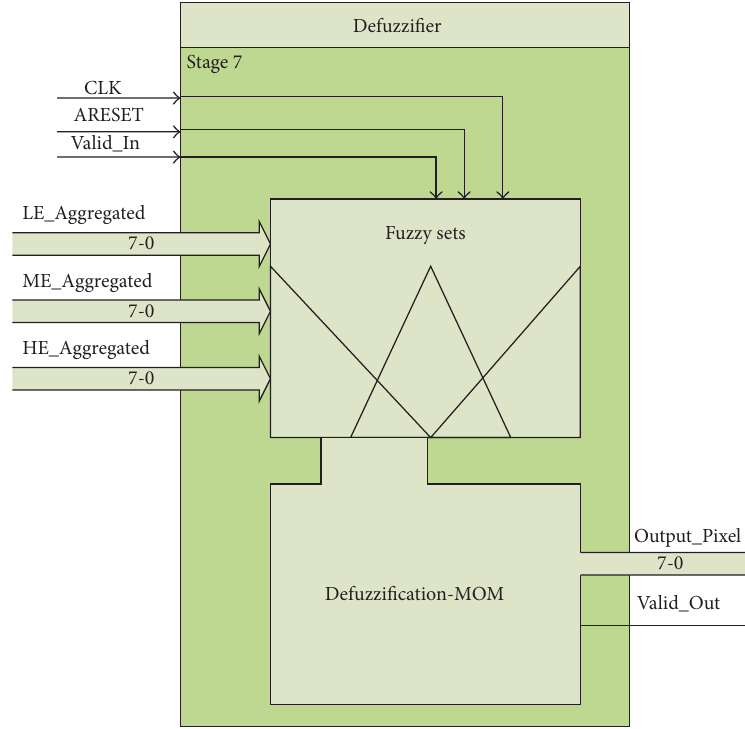
Figure 6: Defuzzification unit functional block diagram.